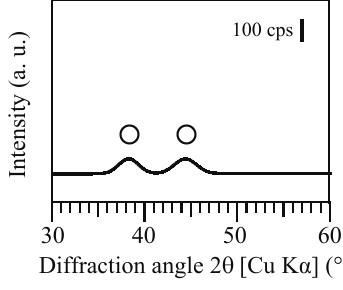
Figure 3. X-ray di ff raction pattern of the resultant Au(0) bionanoparticles produced by Ac. aromatica using 20 mM formate as e-donor. Open circles are assigned to metallic Au(0) (PDF No.